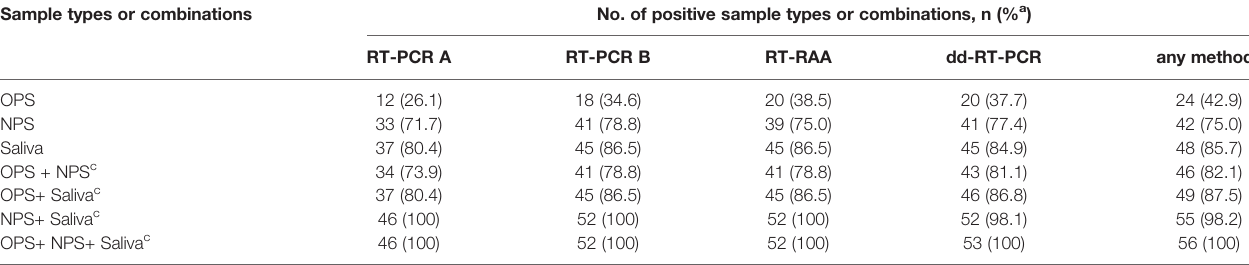
TABLE 6 | Number of positive results detected by different methods using different sample types and sample combinations. Sample types or combinations